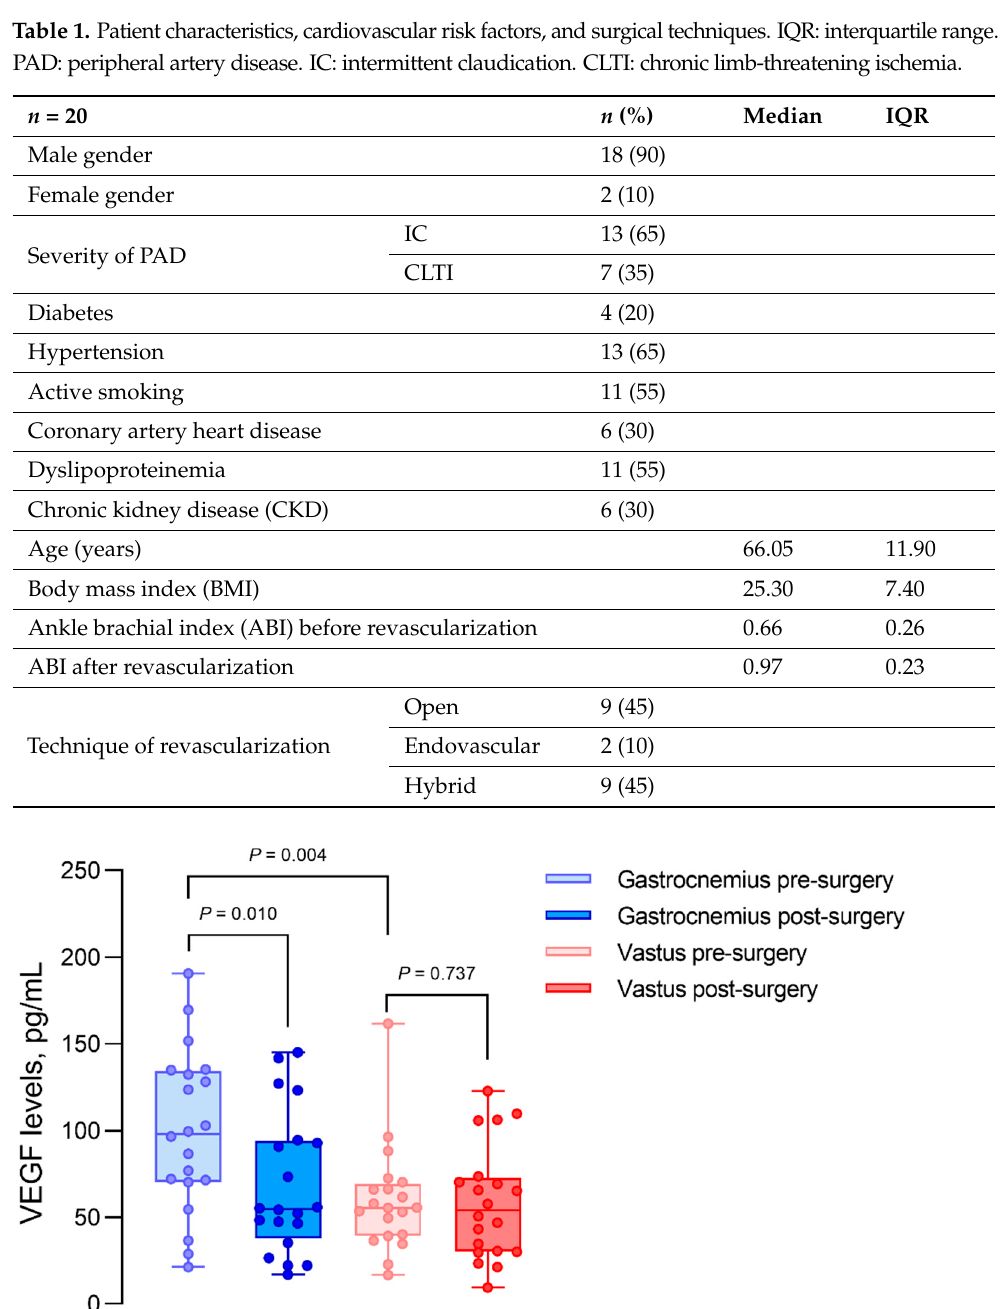
Figure 1. Intramuscular VEGF concentrations in gastrocnemius and vastus lateralis muscle biopsies, before (pre) and after (post) revascularization surgery. Gastrocnemius muscles are considered ischemic, and vastus muscles are considered as non-ischemic